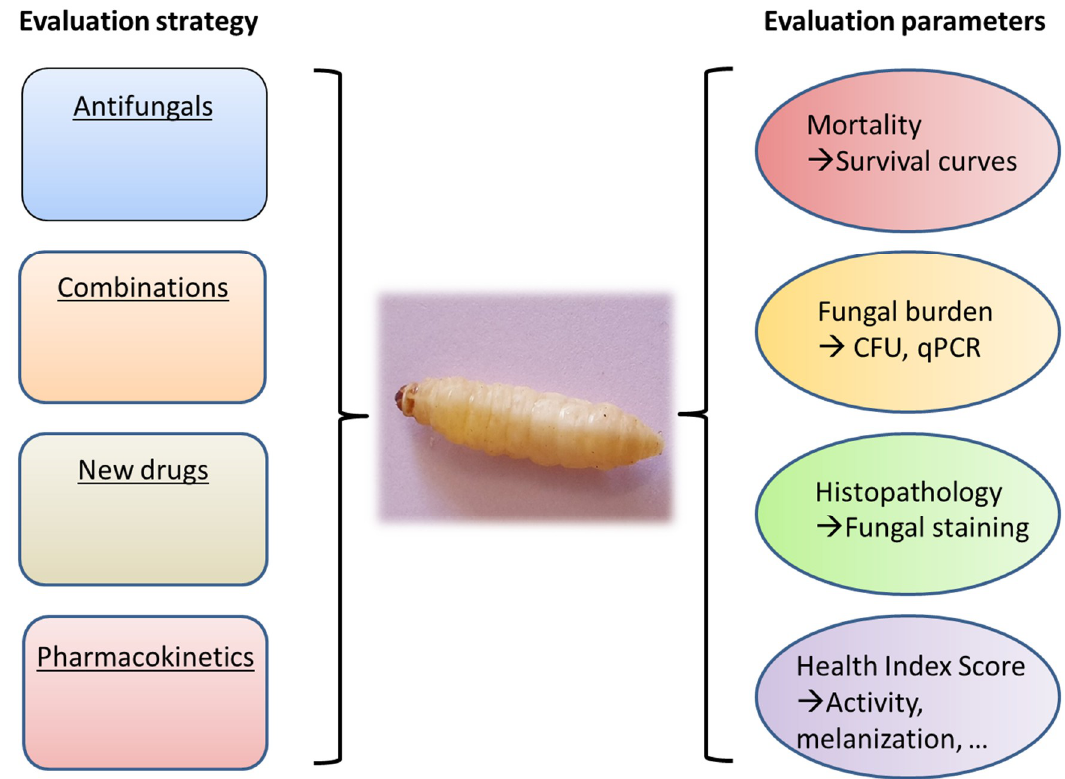
Figure 1. Role of Galleria mellonella for the in vivo evaluation of antifungals.